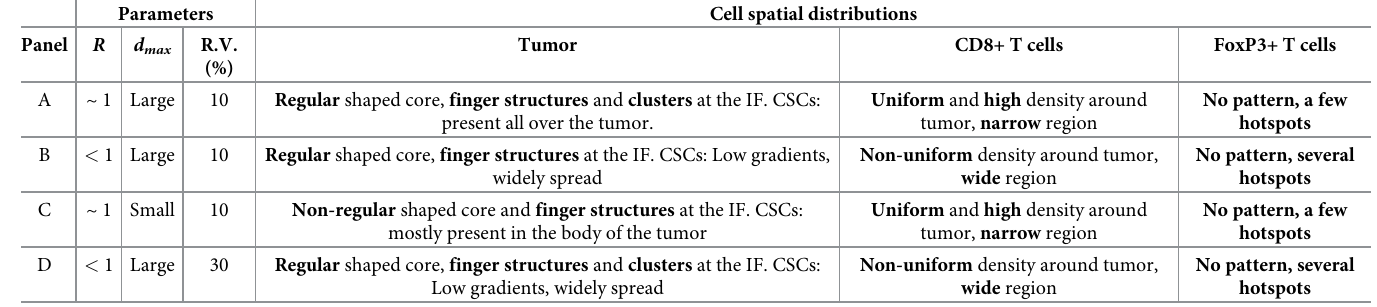
Table 3. Spatial characterization of the immune response under different tumor growth conditions and immunotherapy. R.V. stands for recruitment volume as defined in Table 2; CSCs denotes cancer stem-like cells. Parameters